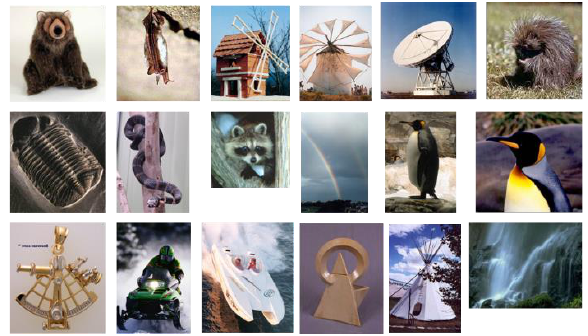
Figure 4. Examples of Caltech256 open dataset.